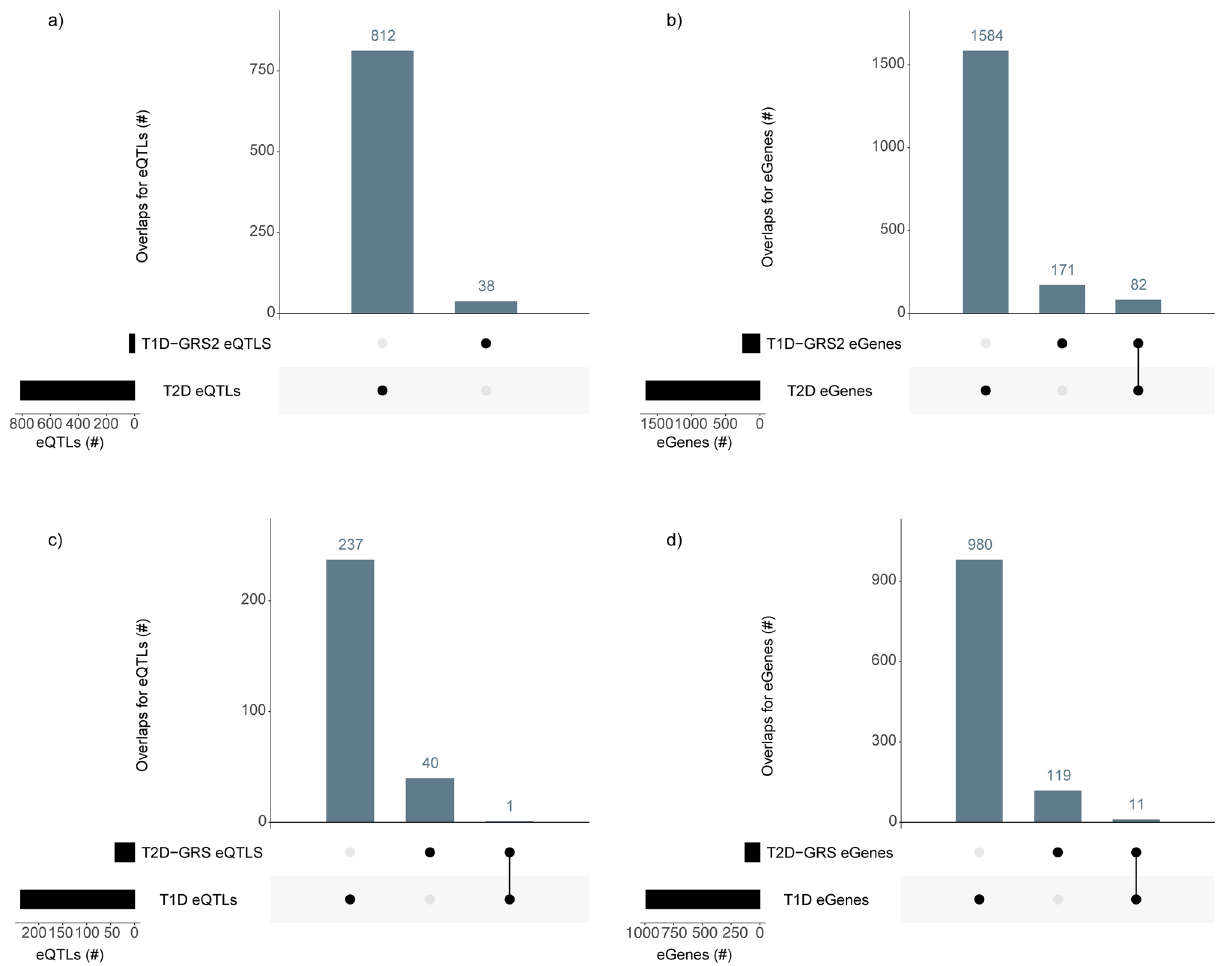
Figure 2. Highly predictive SNPs in polygenic risk scores for T1D and T2D are involved in transcriptional co-regulation of genes that mediate pleiotropic effects. ( a ) The number of unique and shared eQTLs for T1D- GRS2 and T2D SNPs. ( b ) The number of unique and shared genes regulated by spatial regulatory elements marked by T1D-GRS2 and T2D eQTLs. ( c ) The number of unique and shared eQTLs for T2D-GRS and T1D SNPs. ( d ) The number unique and shared genes regulated by regulatory elements marked by T2D-GRS and T1D eQTLs. T1D-GRS2—type 1 diabetes genetic risk score 2, T2D-GRS—type 2 diabetes genetic risk